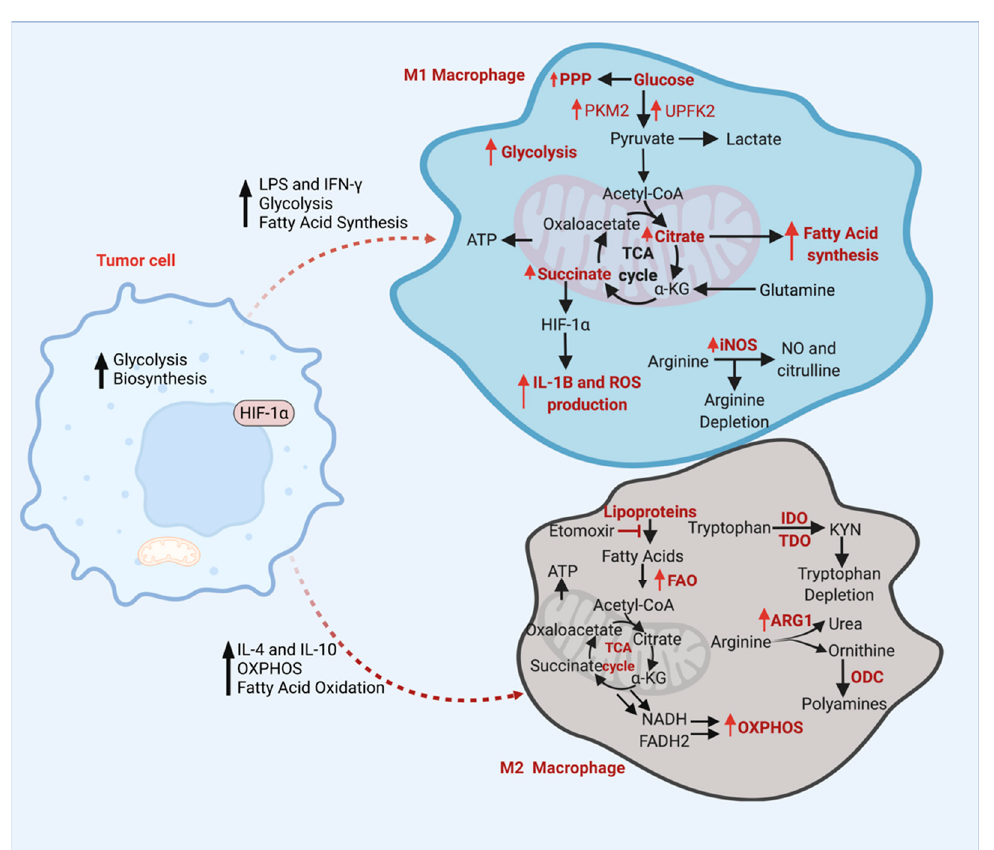
Figure 2. Key metabolic pathways of M1 and M2 Macrophages. M1 macrophages can first be activated by an increase in levels of LPS and IFN- γ , increase in glycolysis, and increase in fatty acid synthesis. Due to the increase in glycolysis, the enzymes PKME and UPFK2 are upregulated, making more pyruvate and increasing the glycolytic metabolism. This increase leads to an increase in PPP, creating more NADPH for ROS and NO production. The increase in pyruvate allows more acetyl CoA to enter the TCA cycle, increasing the levels of citrate and succinate. Higher citrate levels are then used in FAS. Succinate accumulation then regulates HIF1 α leading to further release of IL-1ß and ROS production. Meanwhile, arginine is converted into NO and citrulline via enhanced iNOS activity, further depleting the cell’s arginine levels. M2 macrophages are activated by increased IL-4 and IL-10 levels, increased OXPHOS, and increased fatty acid oxidation. Lipoproteins go through the fatty acid oxidation process and are converted into acetyl-CoA. FAO inhibition can occur by a CPT-1 inhibitor, etomoxir. When acetyl-CoA goes through the TCA cycle, ATP, NADH, and FADH2 are made. The electron carriers NADH and FADH2 are used in OXPHOS. M2 macrophages also cause tryptophan depletion by converting tryptophan into KYN via IDO and TDO enzymes. Arginine is also